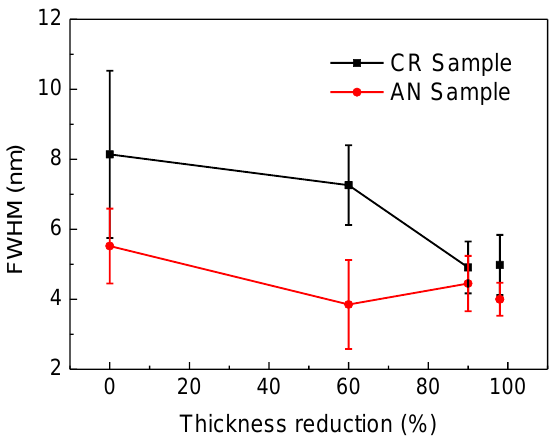
Figure 5. FWHM of the Gauss function fitting curves of the pore size distribution of CR and AN samples as functions of thickness reduction. For the sample with a thickness reduction of 98% a dealloying time of 3 h was used and for the others a dealloying time of 7 h was used.